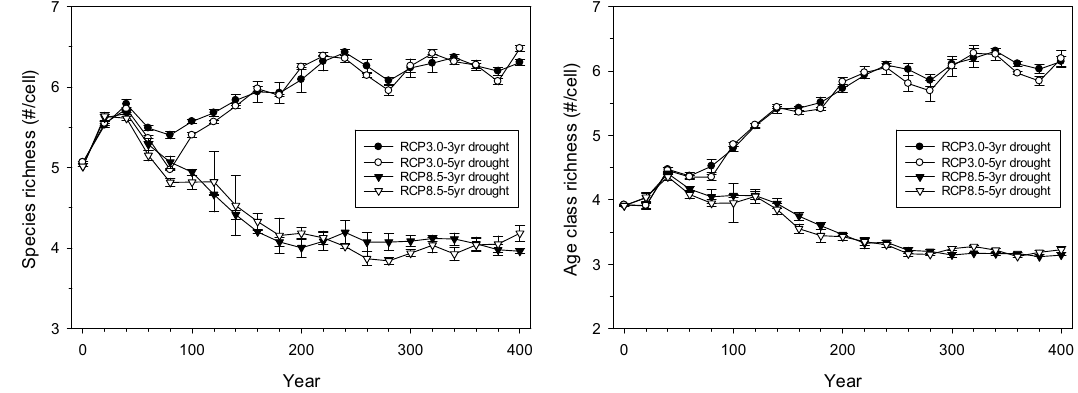
Figure 8. Change in mean richness measures on forested cells through simulated time.